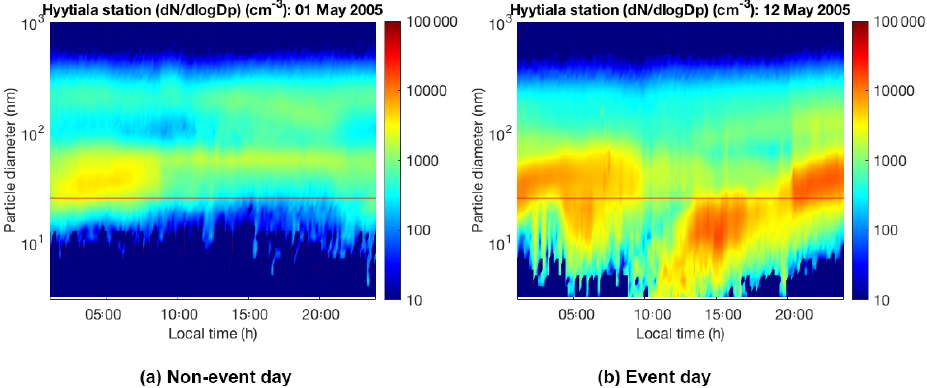
Figure 1. Examples of non-event and event days at Hyytiälä, Finland, in May 2005. A non-event day (a) is assumed when the day is clear of all traces of particle formation whilst an event day (b) occurs when there is a growing new mode in the nucleation size range prevailing over several hours. Data accessed via Smart-SMEAR (Junninen et al.,